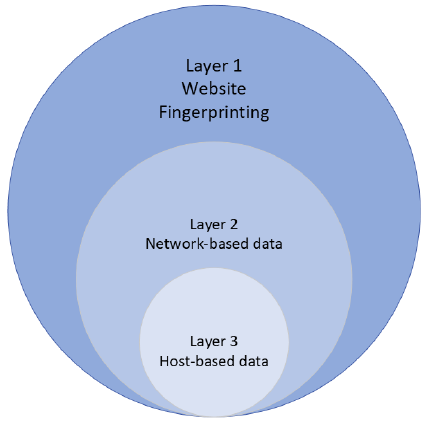
Figure 3. Proposed strategy for the capture of cryptojacking